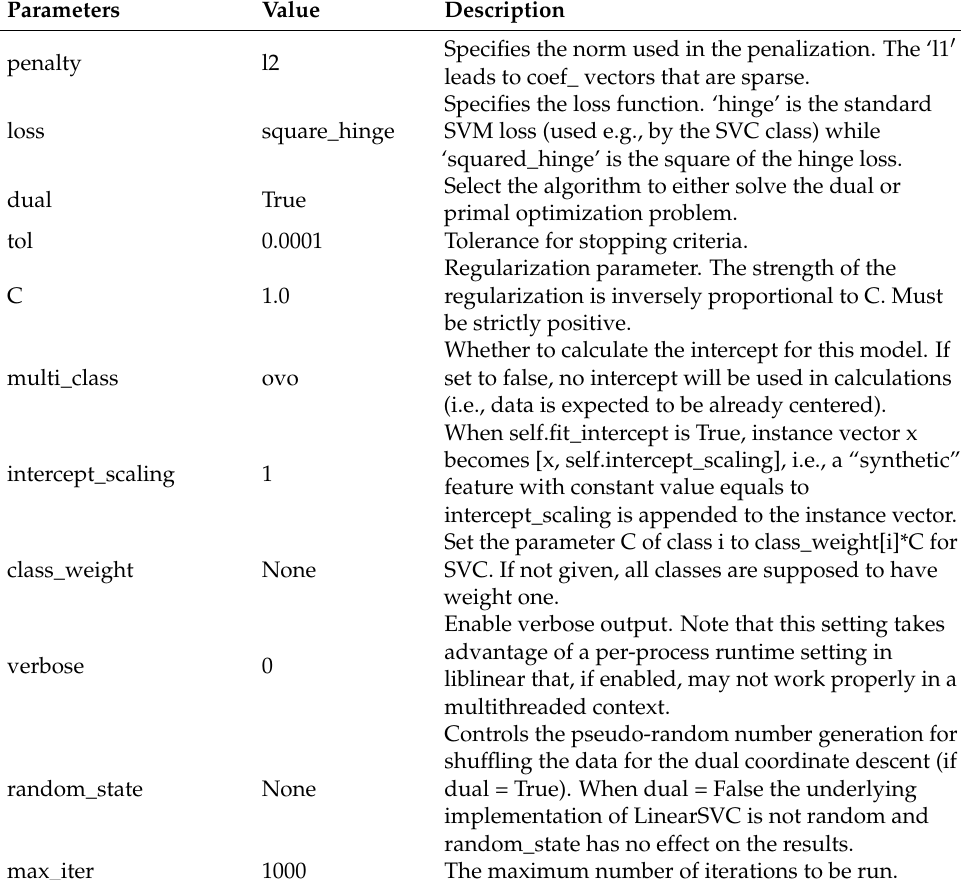
Table 8. LSVM (OVO) parameters from scikit-learn library.